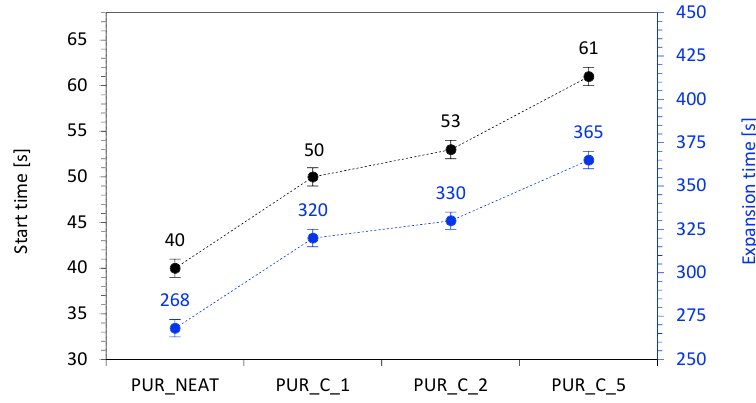
Figure 6. The results for processing times of the PUR systems.